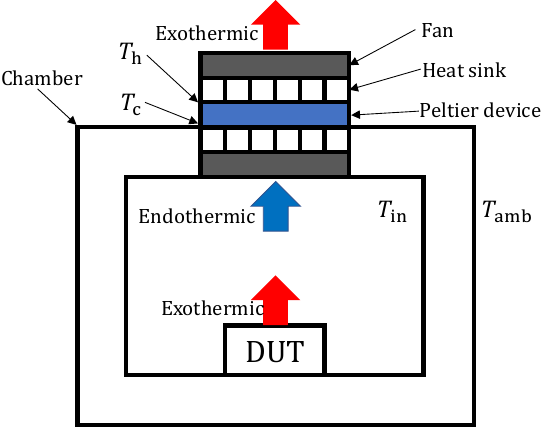
Figure 2. The structure of the calorimetric system using the Peltier device [5].